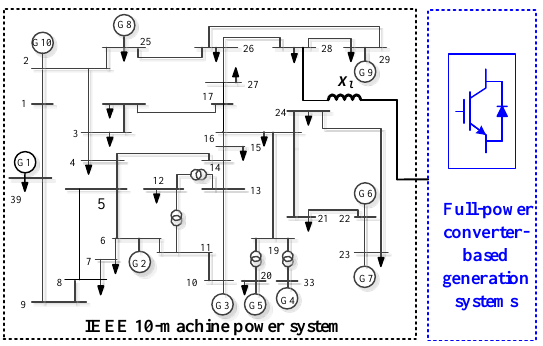
Figure 9. Single-line diagram of the (IEEE) 10-machine power system.